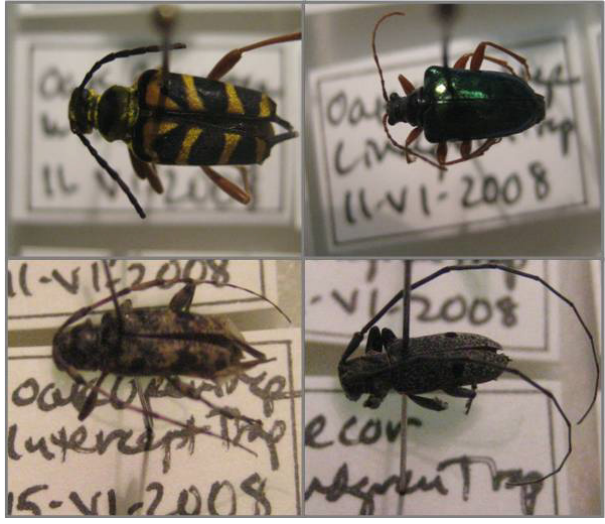
Figure 4. Examples of Cerambycids species that were caught in the 8 forests sampled. Strophiona nitens (top left), Gaurotes cyanipennis (top right) Urographus fasciatus (bottom left) and Microgoes oculatus (bottom